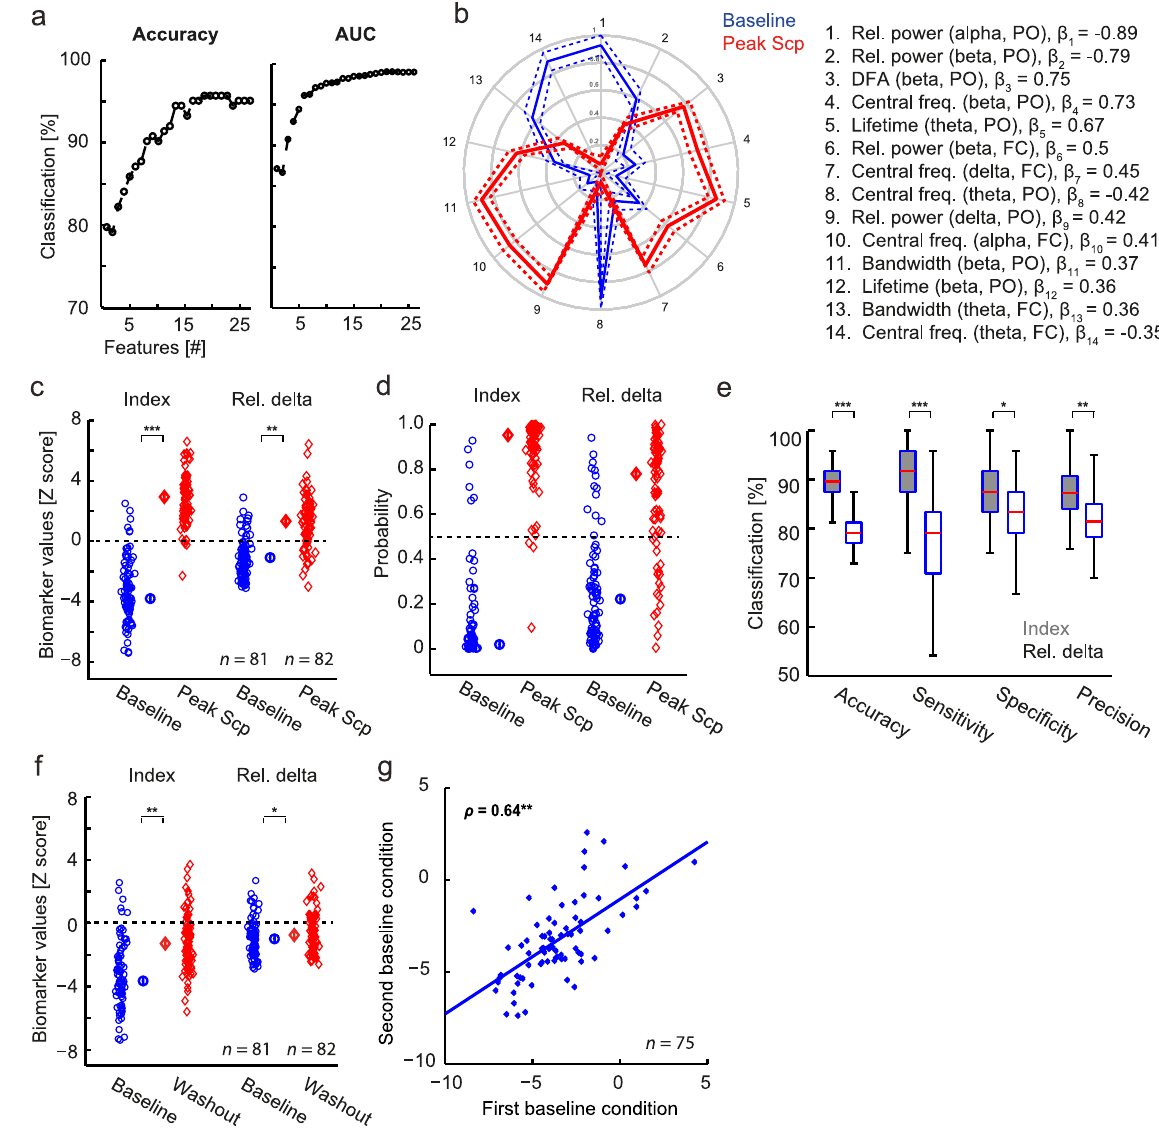
Figure 3. Enhanced detection of scopolamine-induced EEG changes using machine learning. ( a ) Classification performance increased with the number of features included in the integrated index. ( b ) All of the biomarkers selected by elastic net logistic regression for inclusion in the mAChR index differed significantly between baseline and peak scopolamine. Biomarkers are ordered by their absolute weights, decreasing clockwise from the top. Weights ( β ) are listed next to each biomarker in the legend (PO denotes Pz-Oz and FC denotes Fz-Cz). The values plotted on the spider plot are the z-score group means and standard error of the mean, normalized to [0, 1] by subtracting the minimum across all biomarkers and dividing with the largest range present (i.e., the difference between the minimum and maximum value found for the biomarkers with the largest difference). ( c ) The mAChR index was more sensitive to the scopolamine (Scp) intervention than relative delta power. The plot shows z-scored biomarker values per subject recording. Singled-out symbols represent median values per group with standard error bars. The dashed line indicates the threshold of the classifier to predict the recordings as a baseline (below) or a peak scopolamine (above) recording. ( d ) Same as (c) but instead of z-scored biomarker values, predictive probabilities obtained from the classifier are shown. ( e ) Classification performance of baseline vs scopolamine at the peak drug effect using 100 cross-validations is significantly higher for the mAChR index (grey boxplots) than the relative delta power (white boxplots). ( f ) The superiority of the mAChR index was also pronounced at washout. Relative delta power in the scopolamine condition was almost back to normal at 8.5 h after administration, whereas the mAChR index produced a highly significant effect. ( g ) The mAChR index has high test-retest reliability across weeks. Significance levels legend for this figure: * denotes p < 0.05, ** p < 10 − 10 , *** p < 10 − 20 , using Wilcoxon rank sum